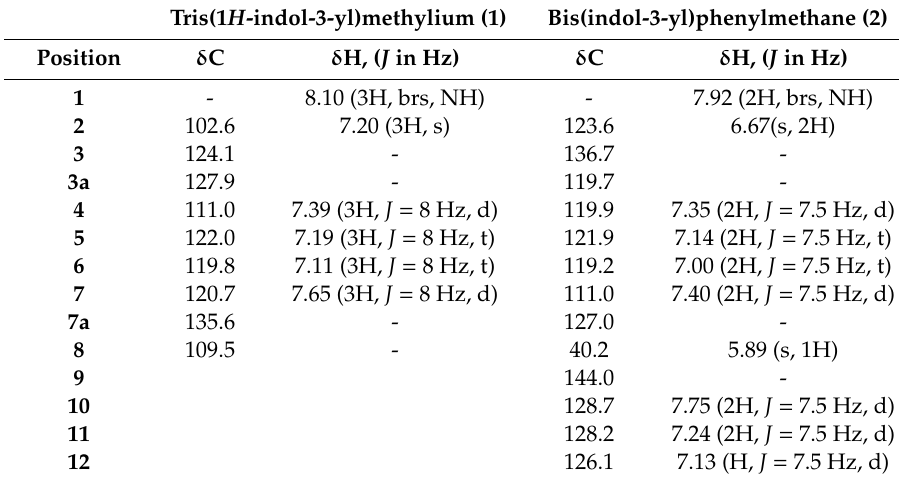
Table 1. H and 13 C NMR data for compounds 1 and 2.